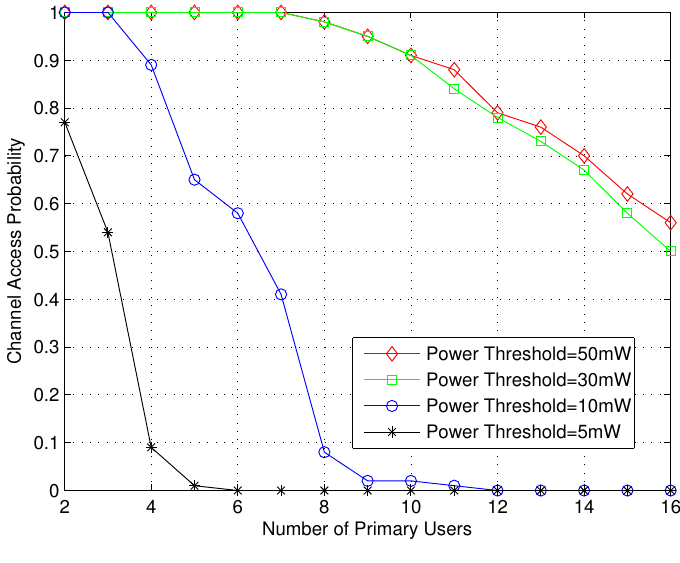
Figure 4. The variation of channel access probability with number of primary users for different power thresholds.